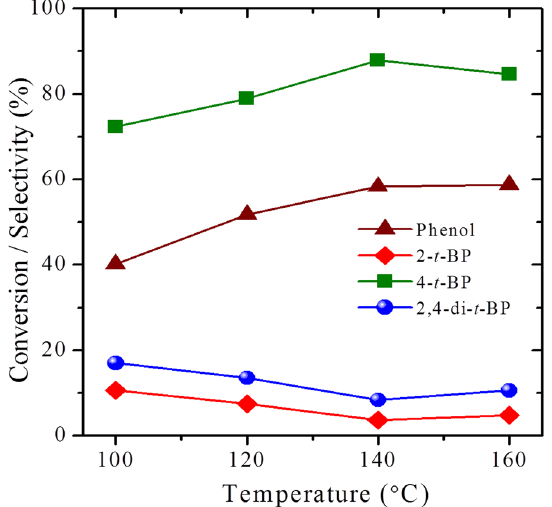
Figure 13. Effect of temperature on catalytic activity of ZH-Y.